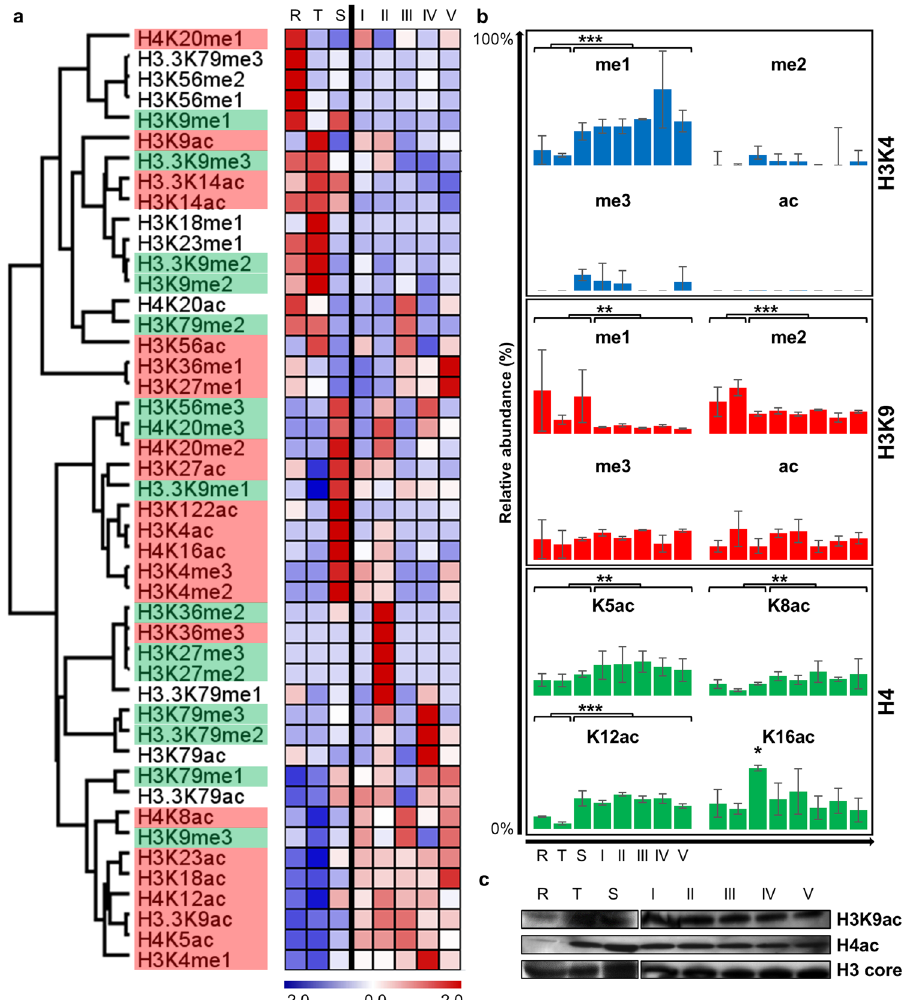
Figure 4. Patterns of gene activation and silencing during life cycle development. ( a ) The histone PTM relative abundance (z-score) over the life cycle is shown (ranging from R, T, S, I, II, III, IV and V from left to right). Z-scores were clustered hierarchically, uncentered (similar results obtained with K-means) with Pearson Correlation on average linkages, and subsequently phase ordered. Euchromatin (red) or heterochromatin (green) status for certain histone PTMs are shown where the information has previously been confirmed in P. falciparum or based on involvement in other model organisms 58, 70–76 . ( b ) The me1, me2, me3 and ac relative abundance levels (%) over life cycle development is shown for histone H3K4, H3K9 and H4 ( *** P < 0.001; ** P < 0.01; * P < 0.05; n = 3 ± SEM). ( c ) Histone H3K9ac, H4ac (K5 + K8 + K12 + K16) and histone H3 (core) levels were independently investigated using immunoblotting over the eight harvested life cycle stages, validating overall lowered levels during rings (except for H3 core) and higher levels from trophozoites and schizonts through gametocytogenesis. Blots were cropped for this image (full-length blots are presented in Supplementary Figure S4). All samples were derived from the same experiments and gels/blots were processed in